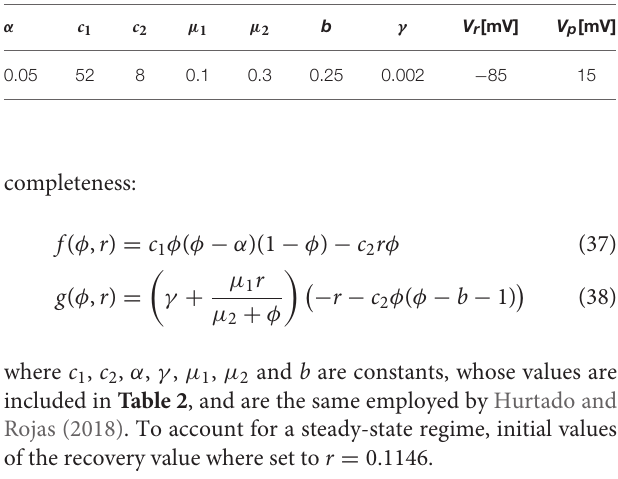
Algorithm 1: Solution algorithm